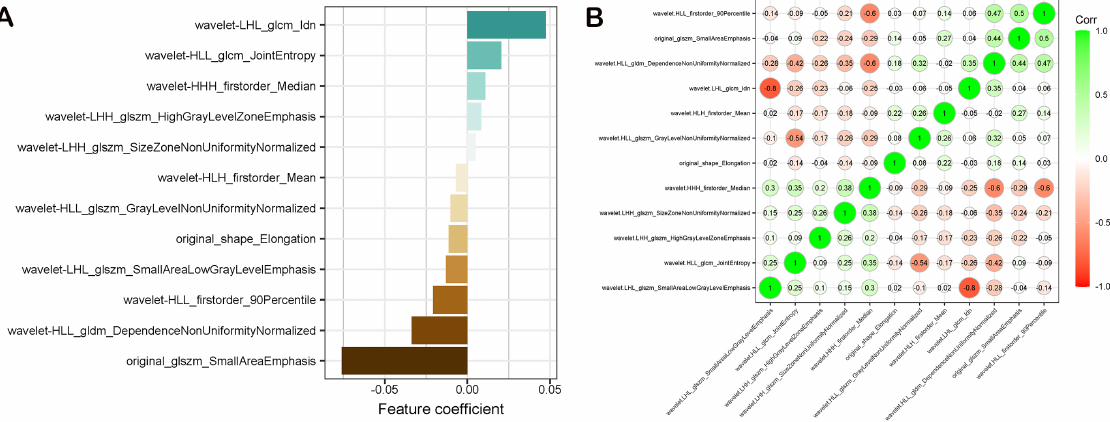
Figure 5. ( A ) The coefficients of radiomics features to construct the Rad-score; ( B ) a Pearson corre- lation coefficient heatmap of the selected features for predicting HER2 status. Green color denotes a positive correlation, the red color denotes a negative correlation, and the shade of the color indi- cates the degree of correlation.